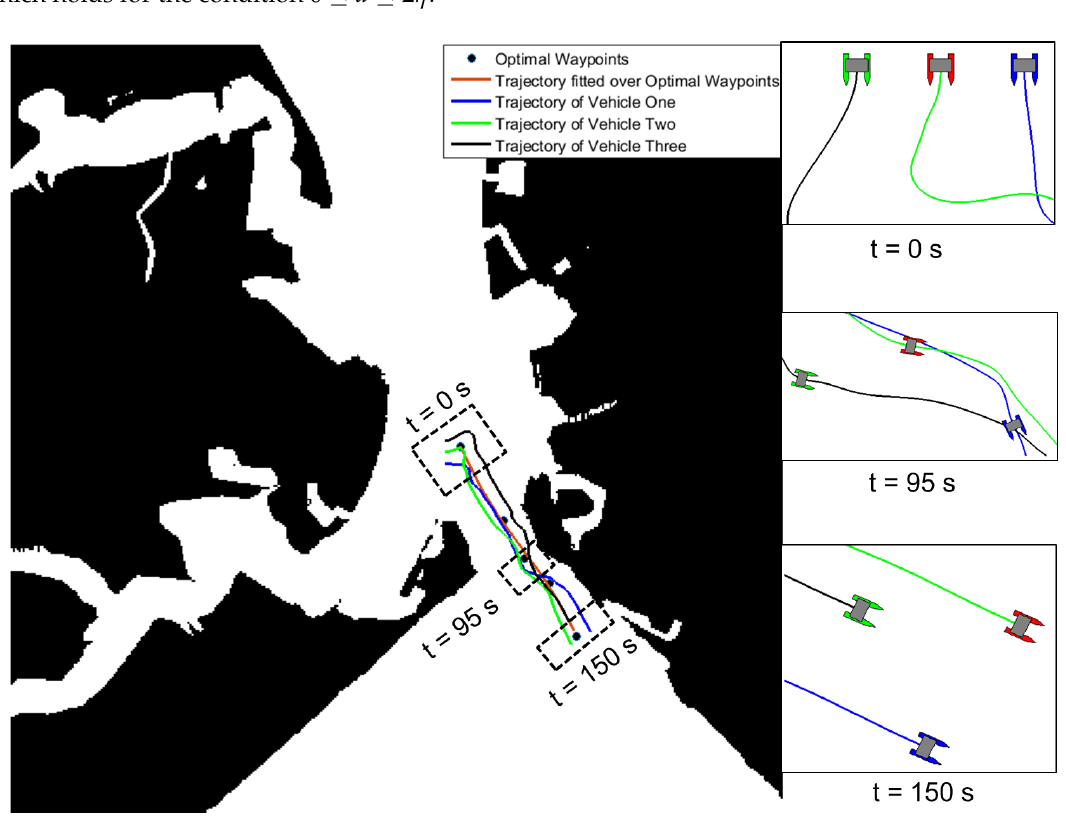
Figure 12. USV motions during swarm aggregation combined with path-following guidance for three